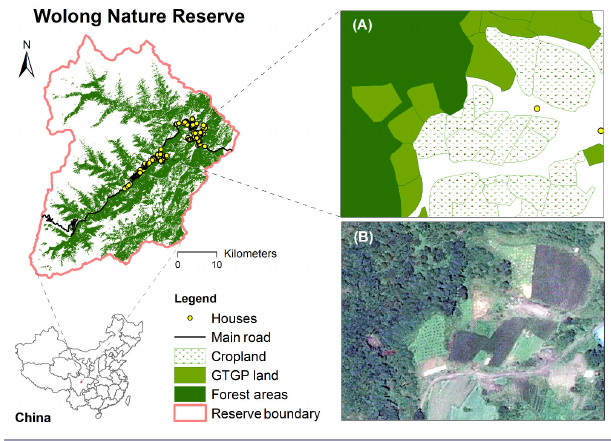
Fig. 2 . Wolong Nature Reserve in Southwest China. Panel (A) shows the digitized information of the distribution of cropland enrolled in the Grain to Green Program (GTGP) (GTGP land) and remaining cropland in a sample area of Wolong. Panel (B) shows the corresponding Google Earth imagery of this sample